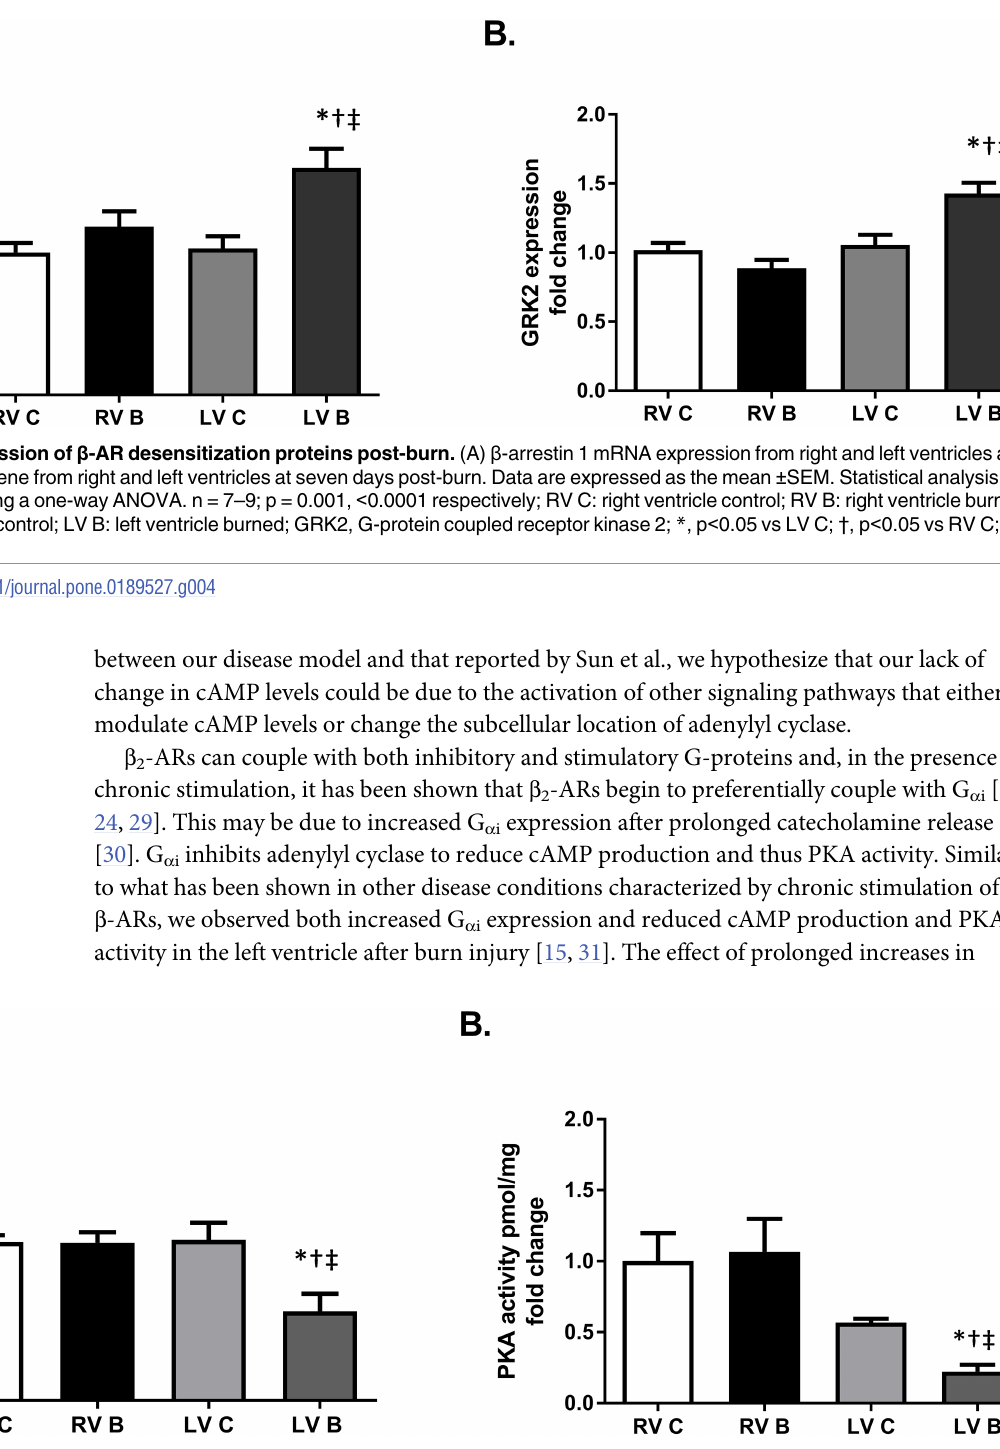
Fig 5. cAMP production and PKA activity post-burn. (A) cAMP productionin membranefractions isolatedfrom right and left ventricles and (B) PKA activity in cytosolic fractions from right and left ventricles,seven days post-burn. Data are expressedas the mean ± SEM. Statistical analysiswas performed using a one-way ANOVA. n = 6–9; p = 0.006 for cAMP; p = 0.004 for PKA; RV C: right ventriclecontrol; RV B: right ventricleburned; LV C: left ventricle control; LV B: left ventricleburned; cAMP, cyclic adenosine monophosphate; PKA, protein kinase A; * , p < 0.05vs LV C; †, p < 0.05vs RV C; ‡, p < 0.05vs RV